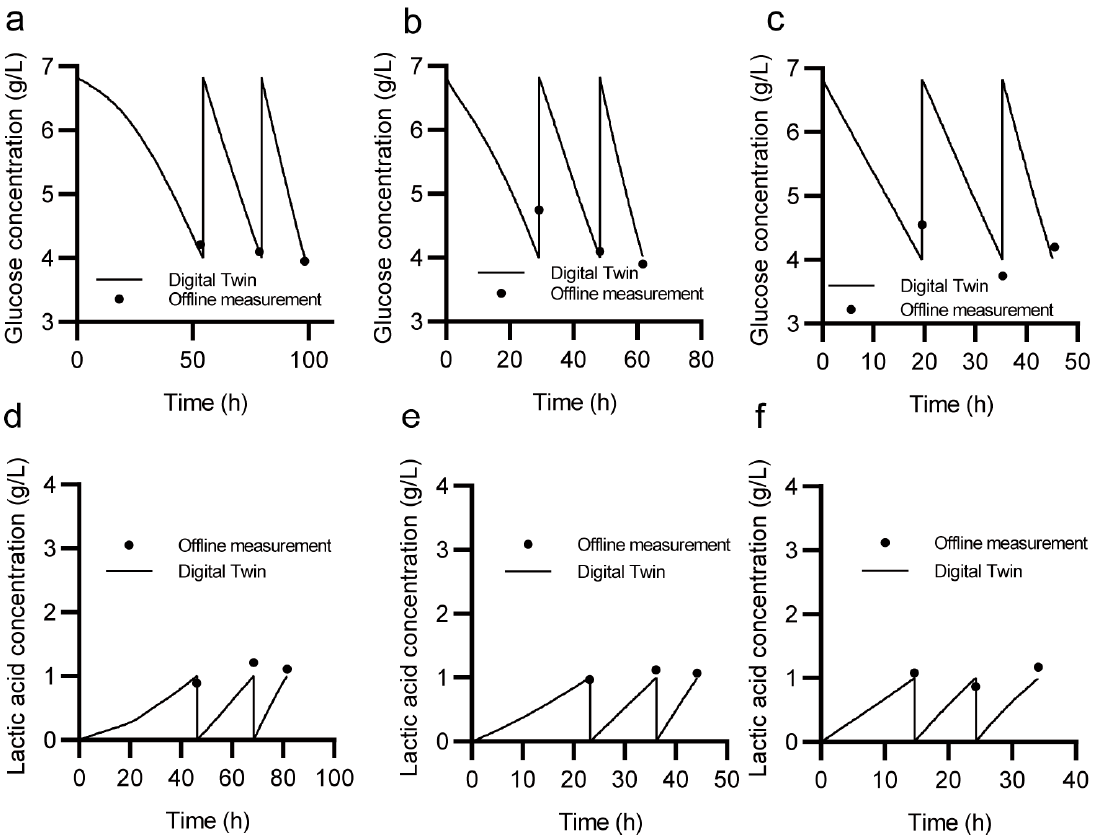
Figure 6. ( a – c ) Prescriptions of media change based on glucose concentration prediction at initial cell densities of 20, 50, and 100 (×10 5 cell/mL). ( d – f ) Prescriptions of media change based on lactic acid concentration predictions with initial cell densities of 20, 50, and 100 (×10 5 cell/mL).